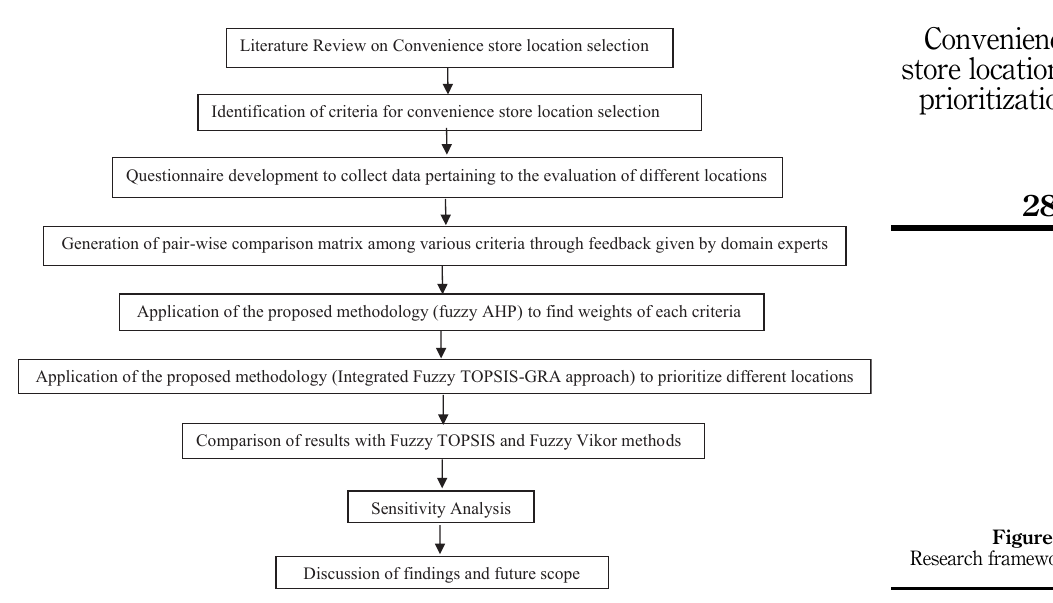
Figure 1. Research framework